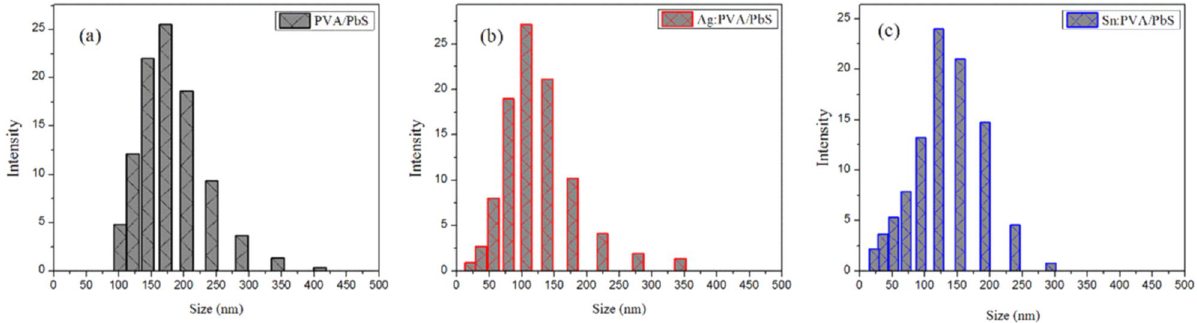
Figure 4. DLS particle size distribution for ( a ) pure PVA/PbS, ( b ) Ag doped PVA/PbS and, ( c ) Sn doped PVA/ PbS.